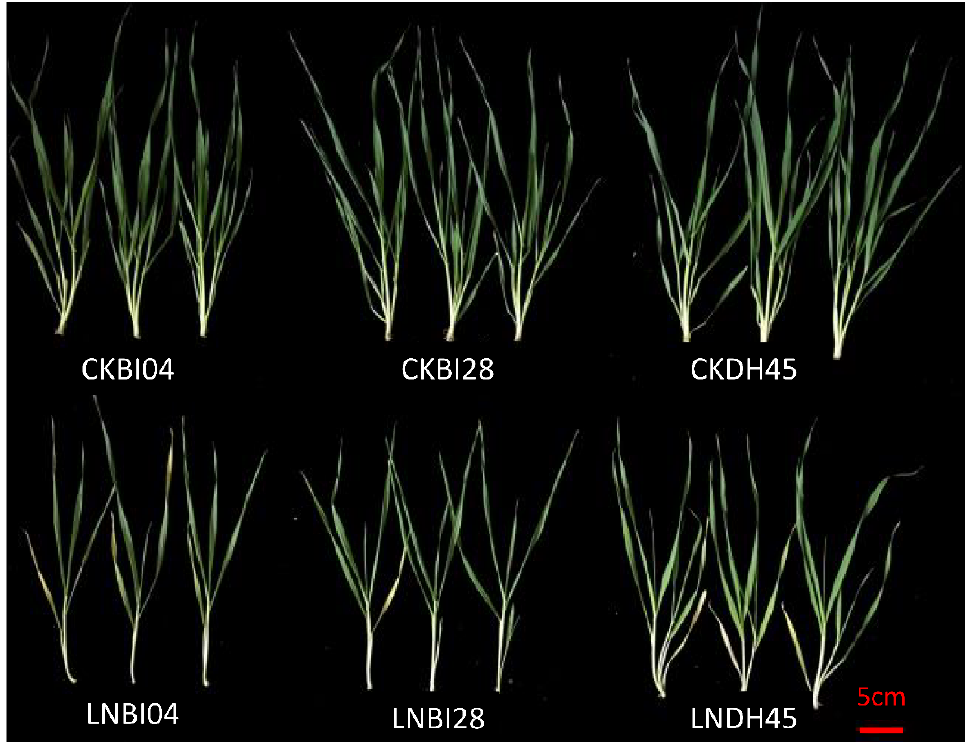
Figure 4. Phenotypic comparison of DH45 and its parents at 28d seedling stage under CK and LN conditions. Table 3. Comparison of shoot biomass and NUE between DH45 and parents at seedling growth stage (Zadoks growth scale 19) in hydroponic culture.